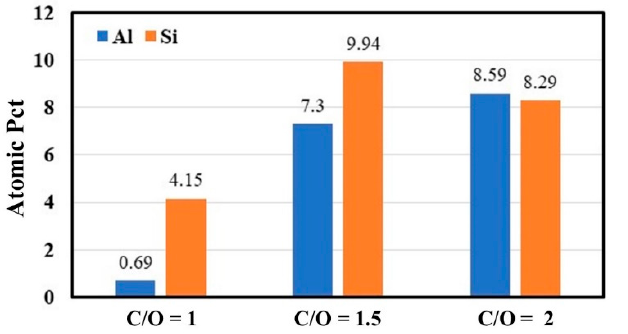
Figure 10. Comparison of elemental atomic percent in the synthesized metal after heating at 1550 °C for 3 h.